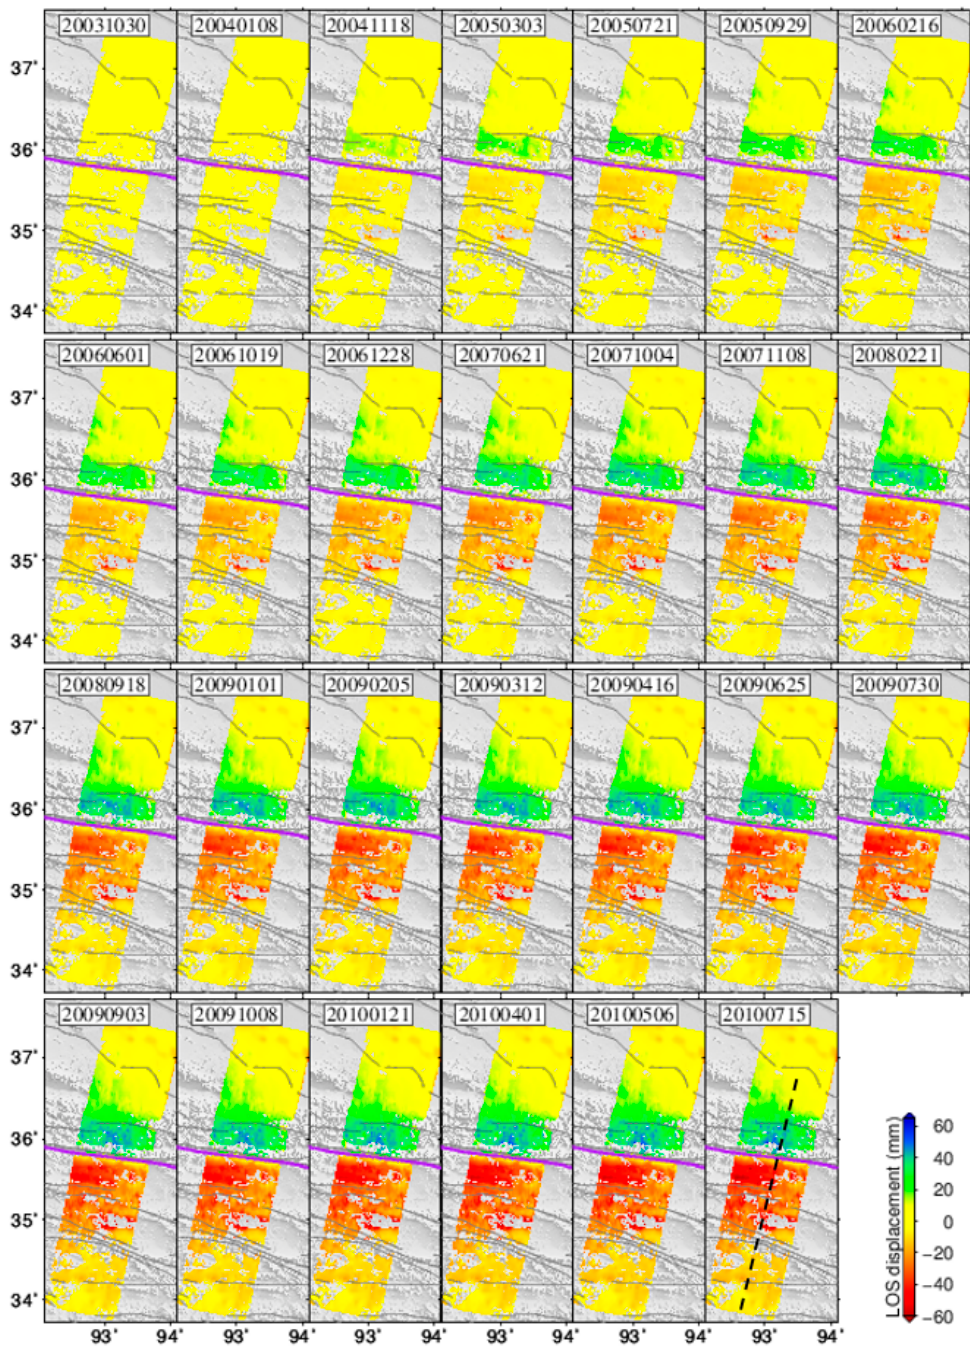
Figure 14. Smoothed InSAR timeseries for Envisat descending track 133. Line of sight (LOS) cumulative displacements are referenced to the first acquisition date, 30 October 2003. Negative range change is toward satellite. The surface ruptures caused by the 2001 Kokoxili earthquake and the active faults are as in Figure 1b. Black dashed line in the last snapshot indicates the location of the profile shown in Figure 15.